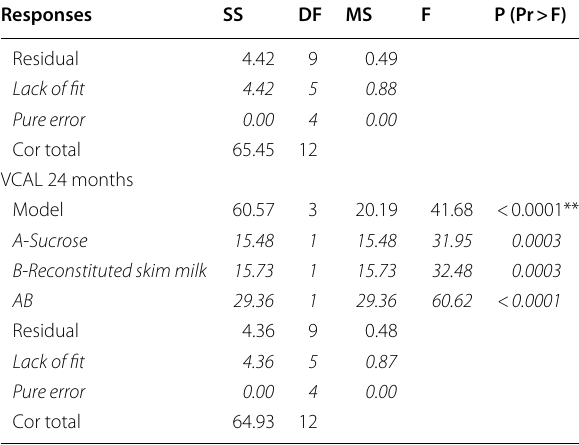
Table 4 Analysis of variance (ANOVA) of all